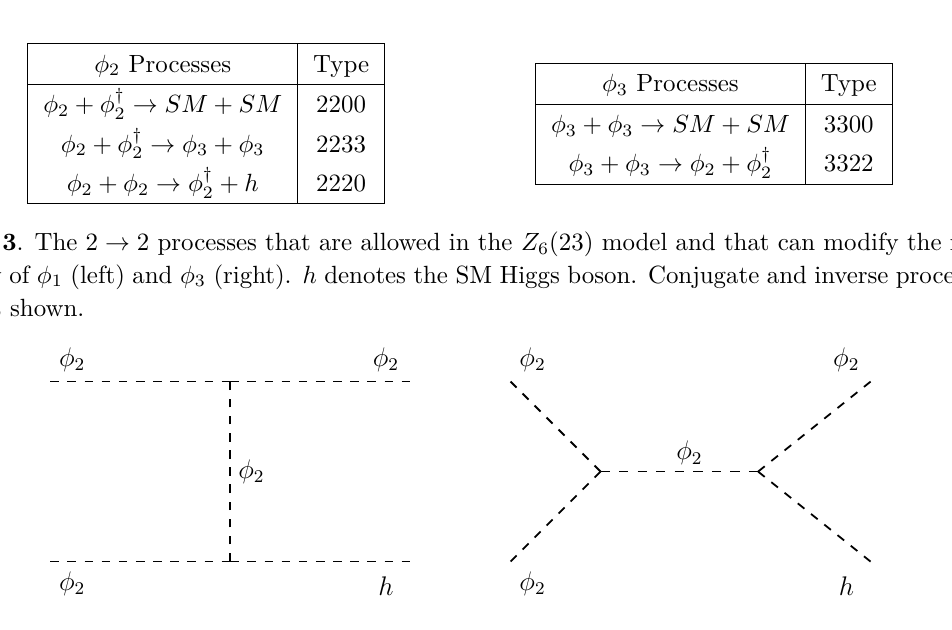
Figure 3 . Semi-annihilation processes in the Z 6 (23) scenario governed by the trilinear self- interaction µ 32 and the Higgs portal λ S 2